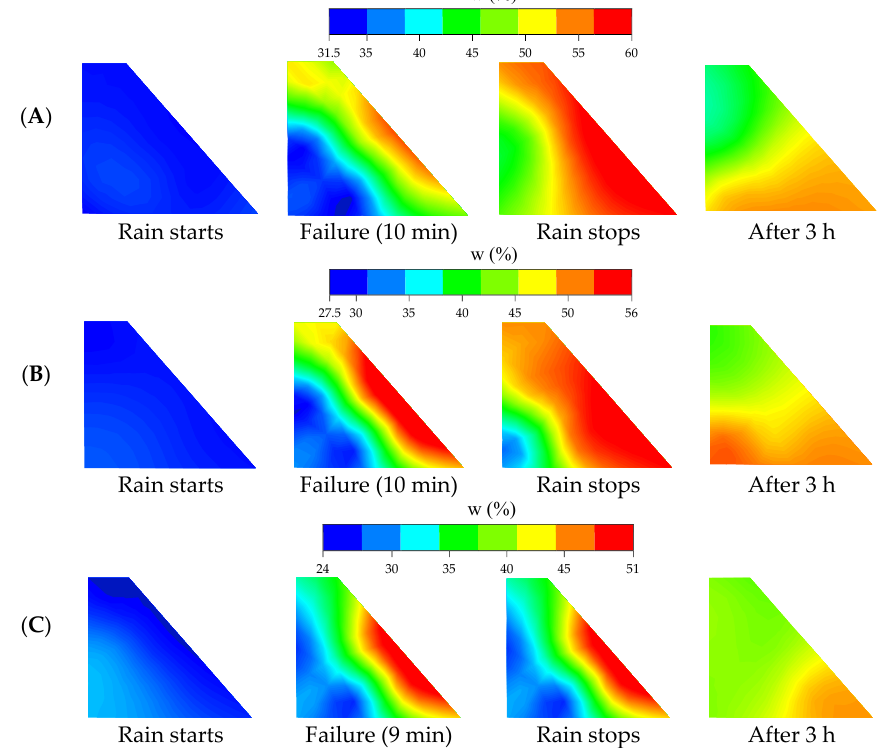
Figure 13. Water content distribution inside model embankments during and after rainfall tests ( A ) K 8.5A, ( B ) K soil, ( C ) and K 40A . The change in pore water pressure during rainfall is shown in Figure 14. In the case of K 8.5A and K soil , pw1 near the crown of the embankment increased faster than pw2 and pw3. Then, flow deformations occurred at the base of the slope when pw3 exceeded 1. For K 40A , the rate of increase in pore water pressure was lower than that of K 8.5A and K soil . The values at three positions, pw1, pw2, and pw3, were almost the same. When the shear strain reached 6%, the pore water pressure was quite small compared with the other two cases. Another difference of K 40A was that the value of pw3 did not decrease for 3 h after the rainfall had stopped. The saturation degree sm4, sm5, and sm6 of K 40A also showed an upward trend after rainfall instead of decreasing as was the case of K 8.5A and K soil . This can be explained through the movement of fine particles. As mentioned above, the fines con- tent in Area 3 was always greater than in Areas 1 and 2. This migration trend led to the concentration of a large amount of fine grain at the toe of the slope. Fine particles com- bined with coarser particles made their size larger than the size of the pores, which